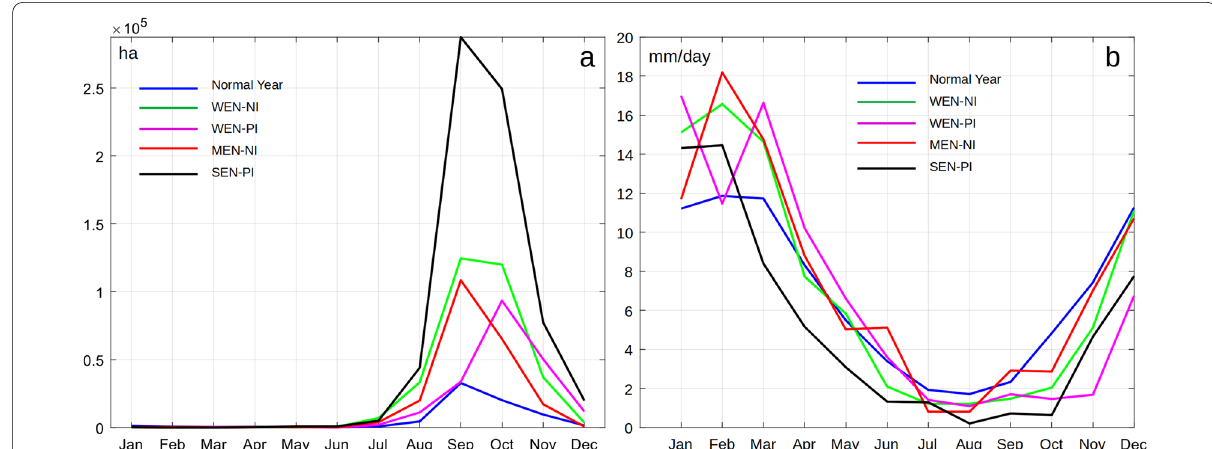
Fig. 3 Temporal of joint pattern for each category on Merauke. Burned area graph ( a ) represents the average total burned area of the composite year. In contrast, the precipitation graph ( b ) represents the average monthly average precipitation from each grid of the composite year for each category